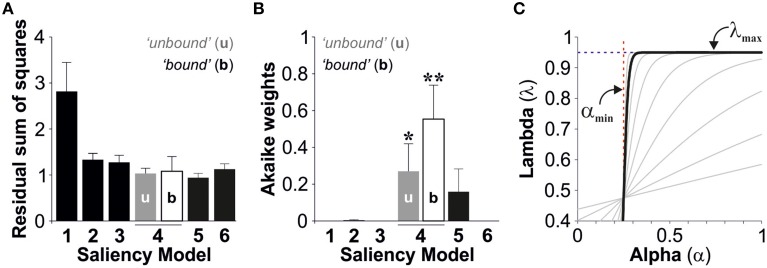
Best model selection. The bar plots display the group average residual sum of squares (A) and the Akaike weights (B) for the saliency models tested (Average ± S.E.M). (C) Plot of lambda vs. alpha using the best parameter fits described in Figure 2 (“bound” conditions). The pattern resembles a Heaviside step function suggesting that lambda does not depend on alpha.